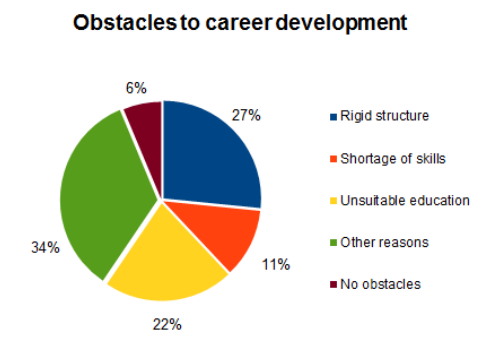
Figure 27 - Career opportunities